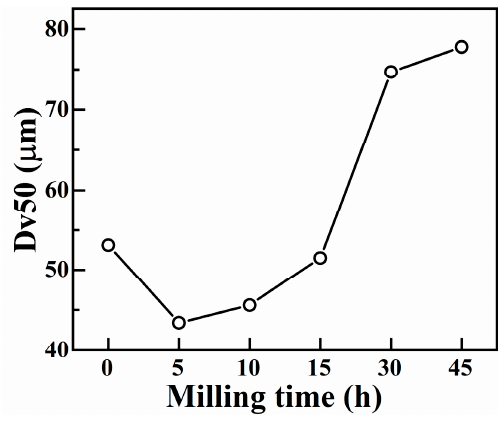
Figure 6. Dv50 of CoCrCuFeMnNi 1.5 HEAP under different milling times.